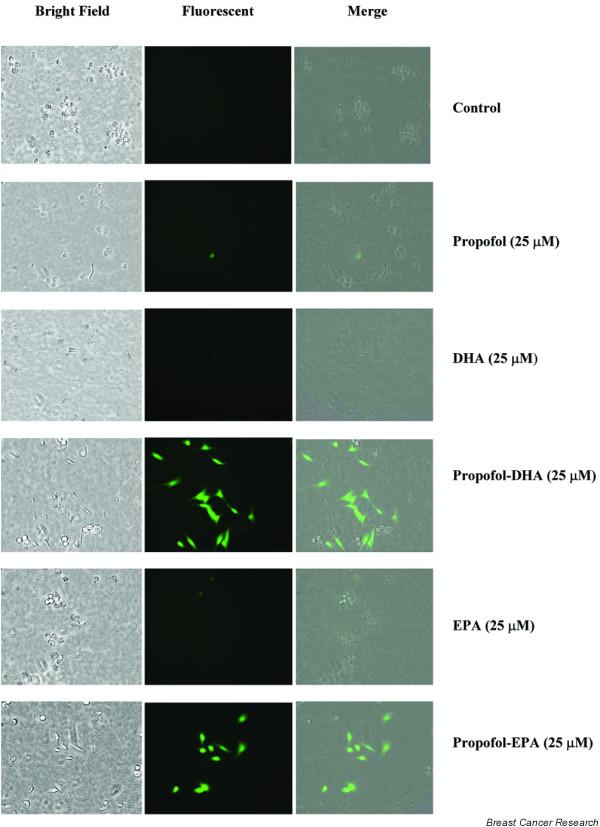
Effect of propofol-docosahexaenoic acid (propofol-DHA) and propofol-eicosapentaenoic acid (propofol-EPA) conjugates on caspase-3 activation. MDA-MB-231 cells (5 × 105 per well) were grown in 96-well plates for 24 hours at 37°C in a humidified CO2 incubator with control or test compounds. Cells containing activated caspase-3 fluoresced green as the result of cleavage of a fluorogenic substrate (Asp-Glu-Val-Asp-fluoromethylketone-aminotrifluoromethylcoumarin conjugate).